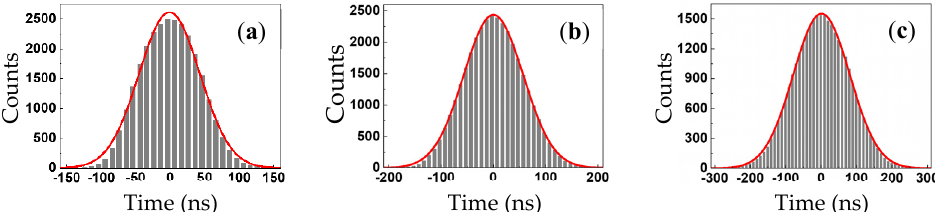
Figure 4. The influence of the three-stage filtering system on the temporal shape of converted pulse. The gray columns are the photon statistics distributions of the converted fields measured by SPD with input FWHM of ∆ t in . Red solid lines are the fitted Gauss distributions with FWHM of ∆ t out . ( a ) ∆ t in = 53 ns, ∆ t out = 102 ns. ( b ) ∆ t in = 112 ns, ∆ t out = 133 ns. ( c ) ∆ t in = 182 ns, ∆ t out = 190 ns. The pumping power is 350 mW. The counts is the accumulation of 5 × 10 5 repeated measurements.